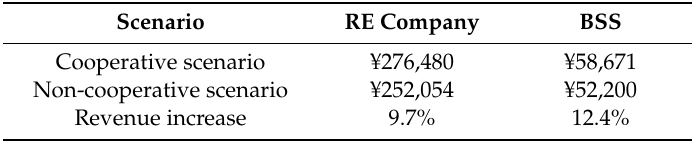
Table 2. The revenue of both sides in di ff erent